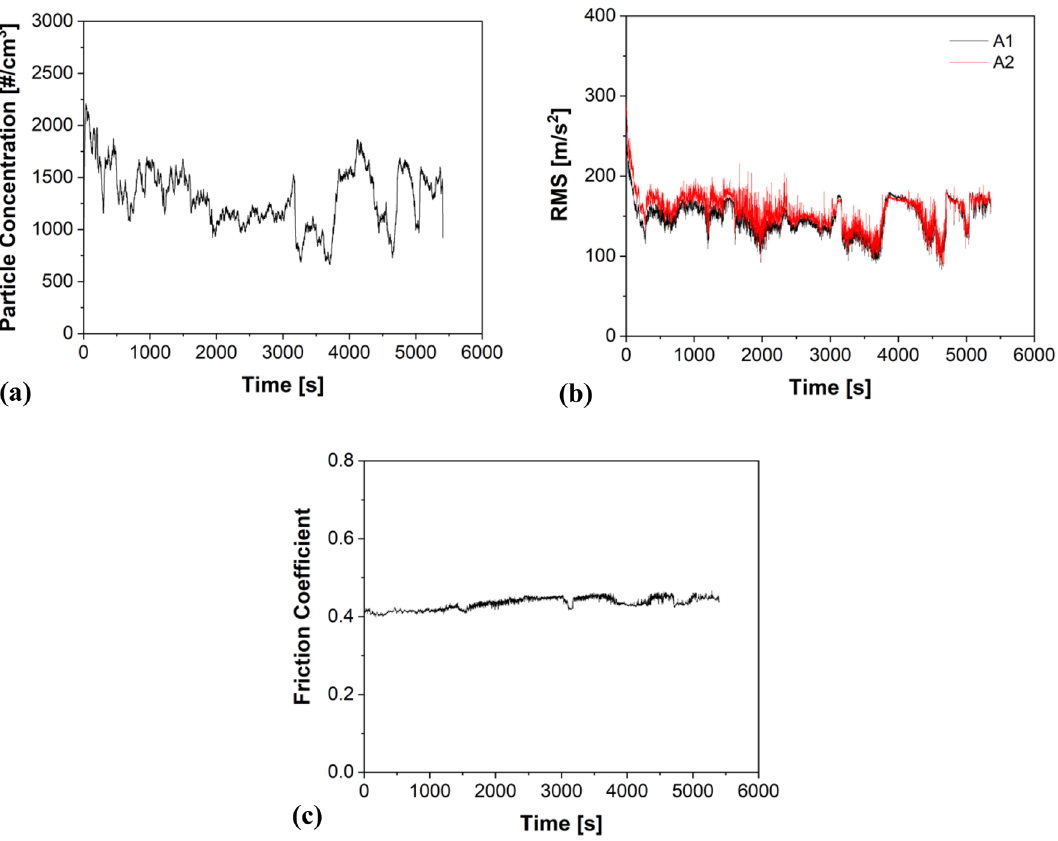
Figure 1. A typical example of ( a ) Emissions; ( b ) Vibrations; and ( c ) CoF trends demonstrated by MC